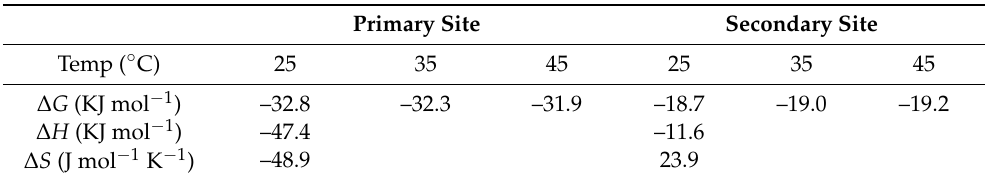
Figure 8. ( A ) Van’t Hoff plots of HSA–indomethacin interaction for primary and secondary sites. ( B ) Far-UV CD spectra of HSA (3 µM) in the absence and presence of indomethacin at 25 °C. Table 4. Thermodynamic parameters of the interaction between HSA and indomethacin obtained using the corrected data at the excitation wavelength of 295 nm at the primary and secondary site.